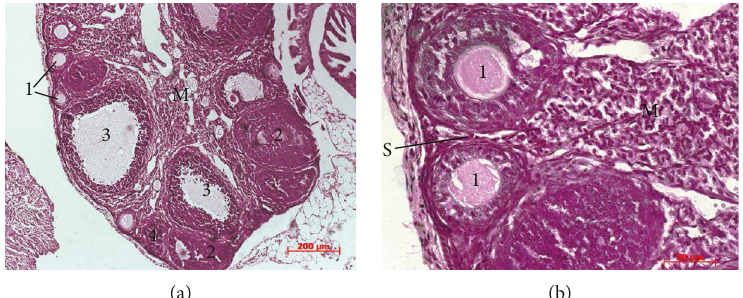
Figure 3: Histological structure of intact ovaries. Ovarian follicles in di ff erent stages of development (primary (1), preantral (2), and antral (3) follicles) and corpora lutea (4) were separated by a stroma (S). The environment of antral follicles is homogeneous with poor eosin staining. The medulla of ovaries (M) consisted mainly of loose connective tissue and blood vessels. Hematoxylin and eosin staining.